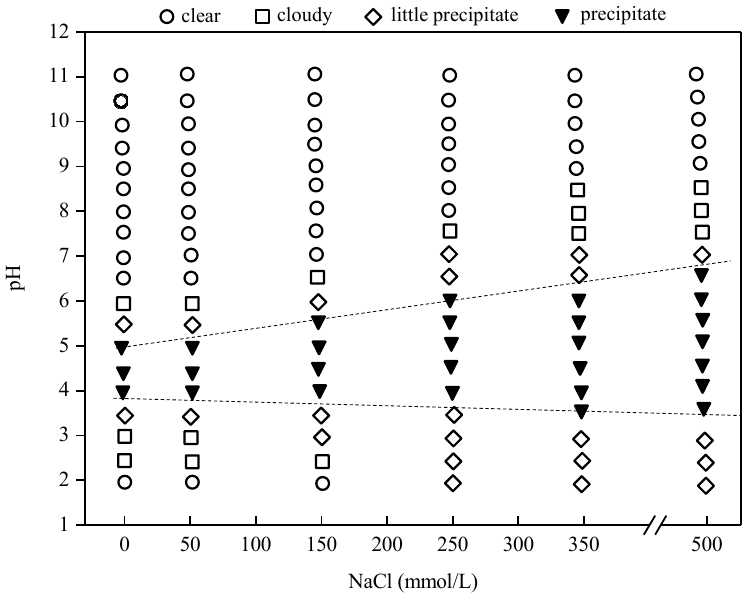
Figure 3. Phase diagram of PSP in aqueous solution.